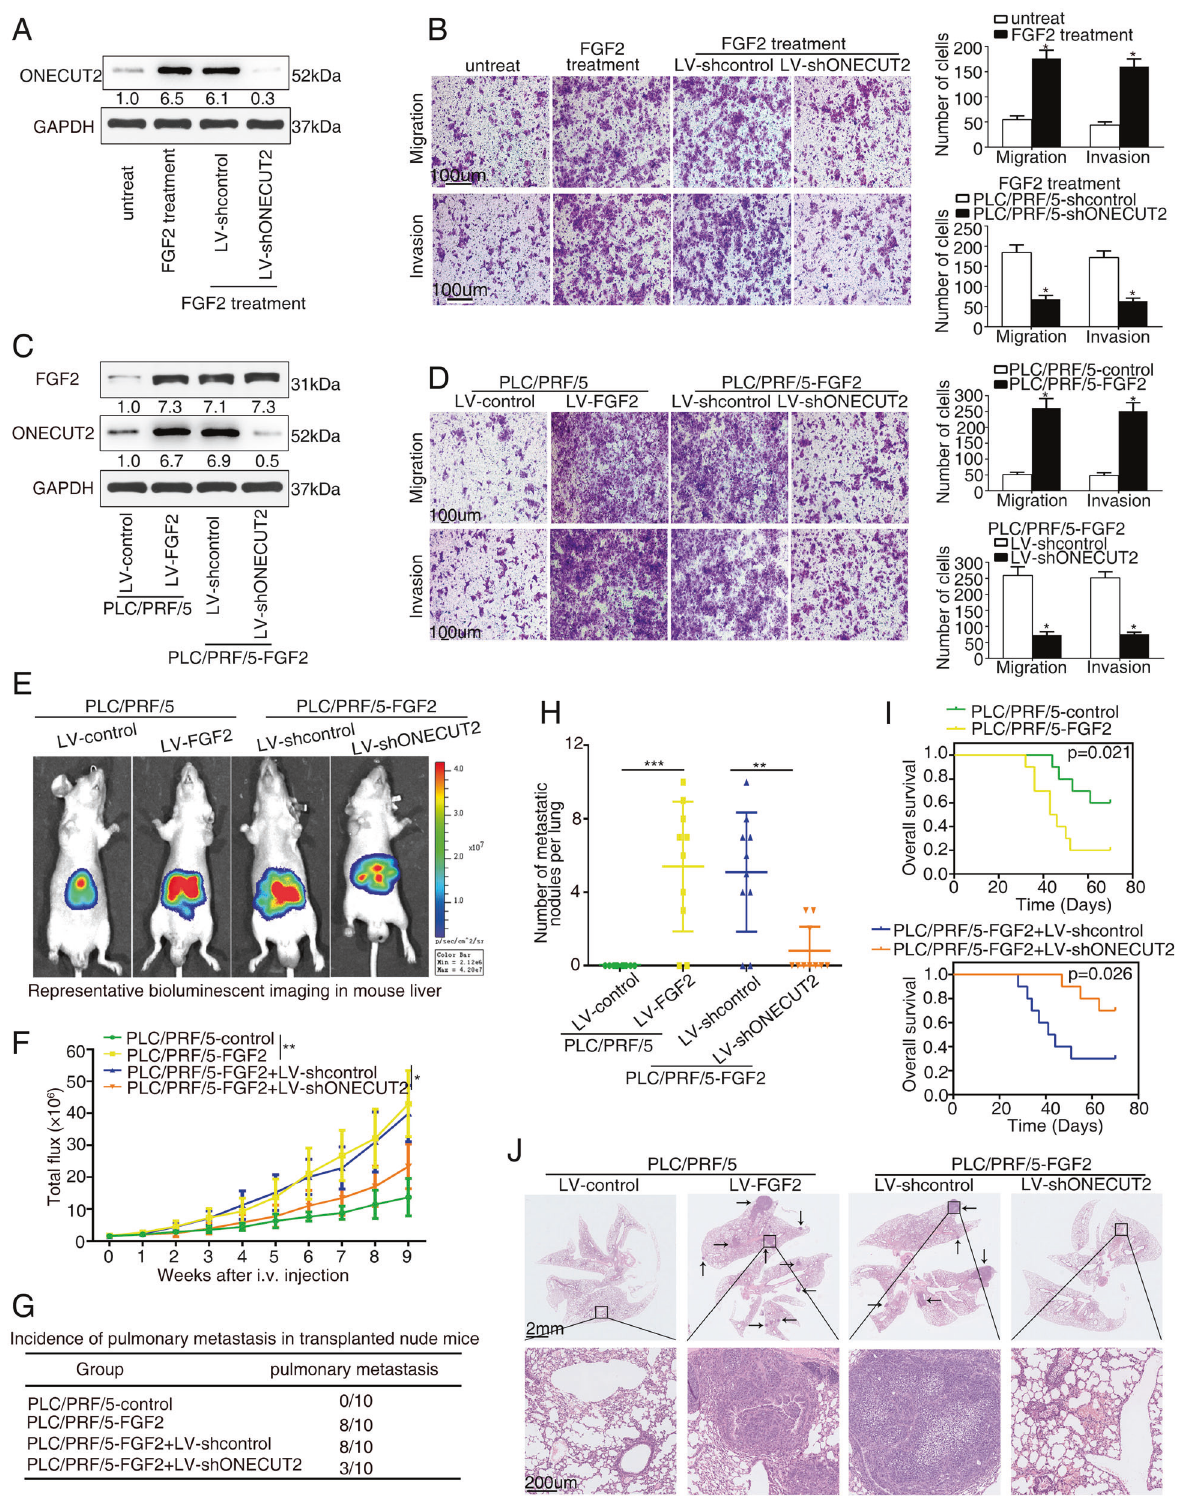
Fig. 6 ONECUT2 is crucial for FGF2-induced HCC metastasis. A Protein levels of ONECUT2 were measured in PLC/PRF/5 cells after ONECUT2 knockdown and FGF2 treatment (20 ng/ml, 24 h) by western blotting. B Transwell assays were used to evaluate migration and invasion of PLC/ PRF/5 cells after ONECUT2 knockdown and FGF2 treatment (20 ng/ml, 24 h). C Protein levels of FGF2 and ONECUT2 were measured in PLC/ PRF/5 cells after FGF2 overexpression and ONECUT2 knockdown by western blotting. D Transwell assays were used to evaluate migration and invasion of PLC/PRF/5 cells after FGF2 overexpression and ONECUT2 knockdown. E – J ONECUT2 knockdown inhibited FGF2-enhanced HCC metastasis. Representative bioluminescent imaging ( E ), bioluminescent signals ( F ), the incidence of pulmonary metastasis ( G ), number of pulmonary metastasis foci ( H ), overall survival ( I ), and H&E staining of the lungs ( J ) among four groups with ten mice in each group 9 weeks after orthotopic implantation of the indicated cells. Data are mean ± SD. * P < 0.05, ** P < 0.01. Cell Death and Disease (2021)